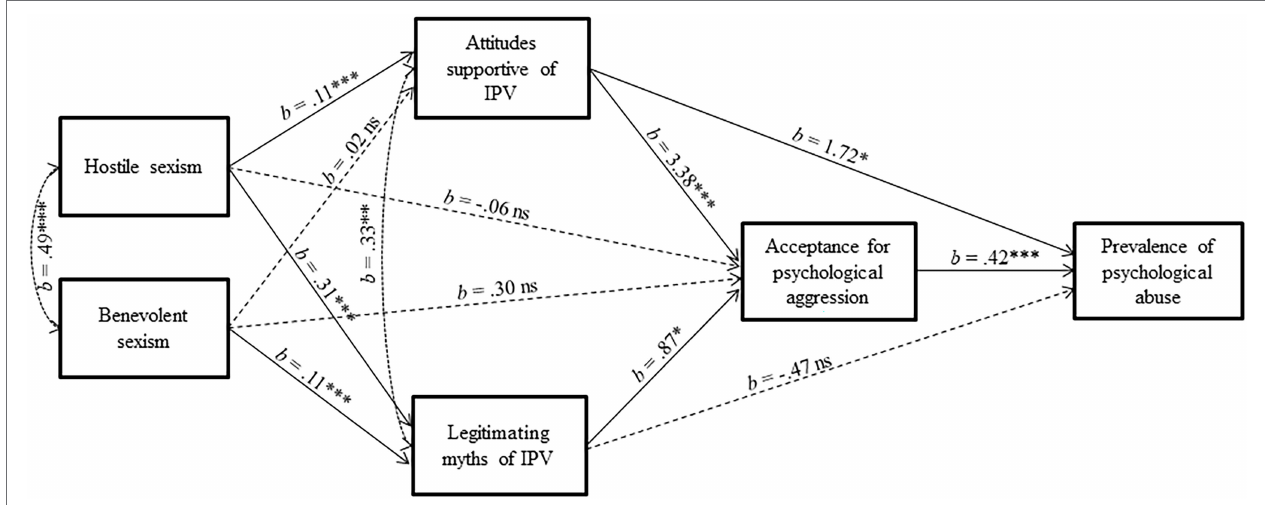
FIGURE 1 | Results of mediation analysis testing the indirect effects of hostile sexism and benevolent sexism on prevalence of psychological abuse via attitudes supportive of IPV, legitimating myths of IPV, and acceptance of psychological aggression. N = 408. *** p < 0.001; ** p < 0.01; * p < 0.05.